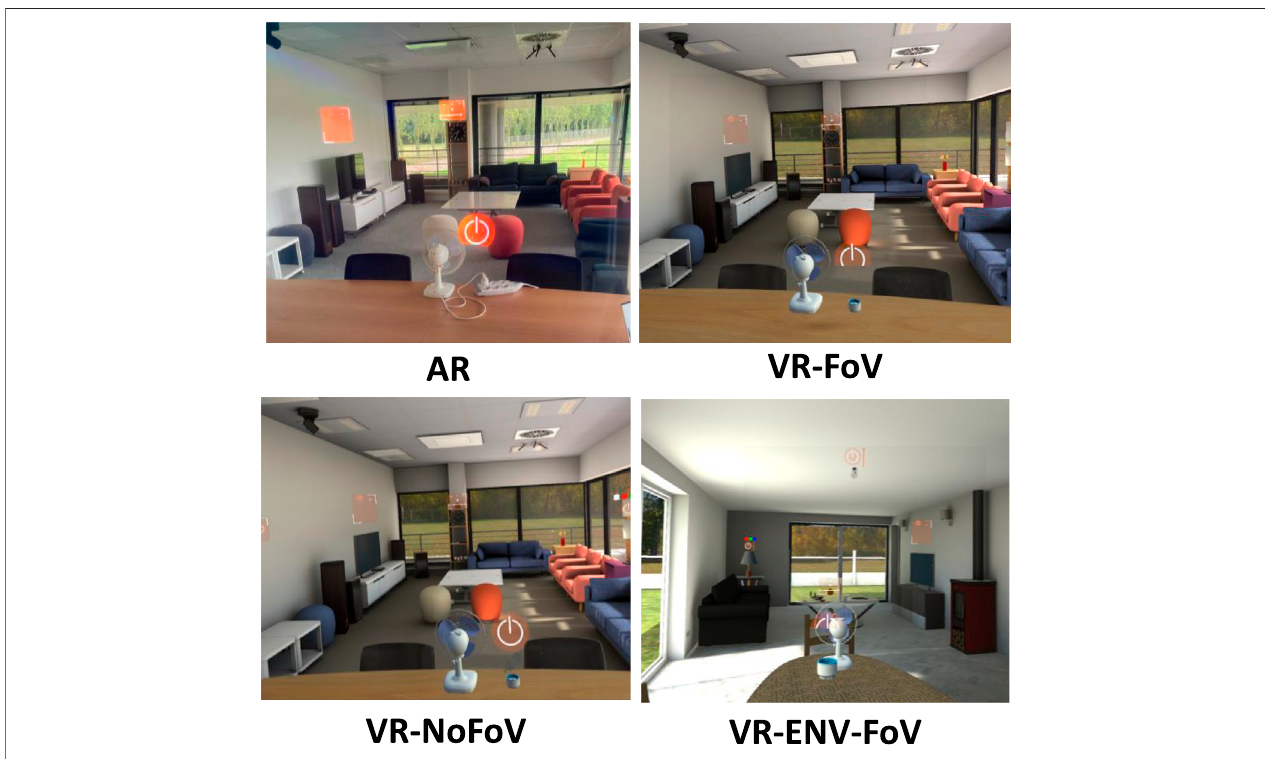
FIGURE 1 | Our four experimental conditions. One group of users performed the experiment in AR. Three groups of users performed the experiment in VR with differentsimulations conditions: simulatedAR FoV ornot, same or different simulatedenvironment. The combination witha different environment and without simulating the AR FoV was not